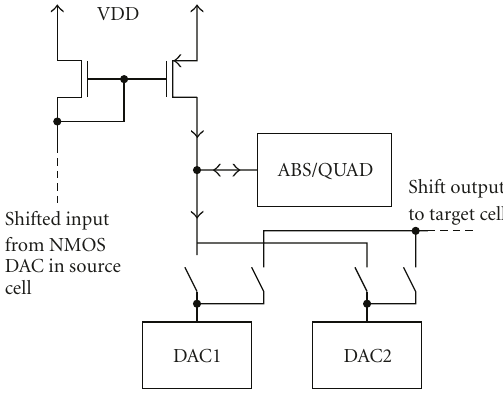
Figure 5: Input configuration for current shift with DAC